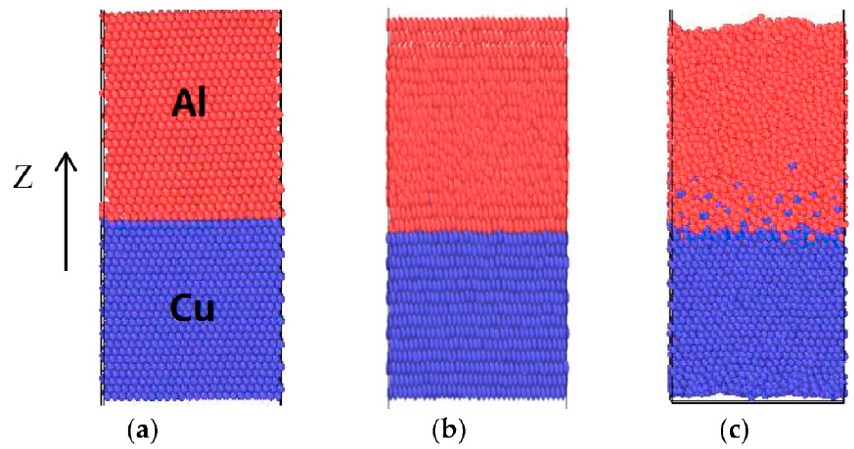
Figure 1. Model of Cu/Al composite panels at different average temperature: ( a ) 0 K; ( b ) 710 K; ( c ) 930 K.